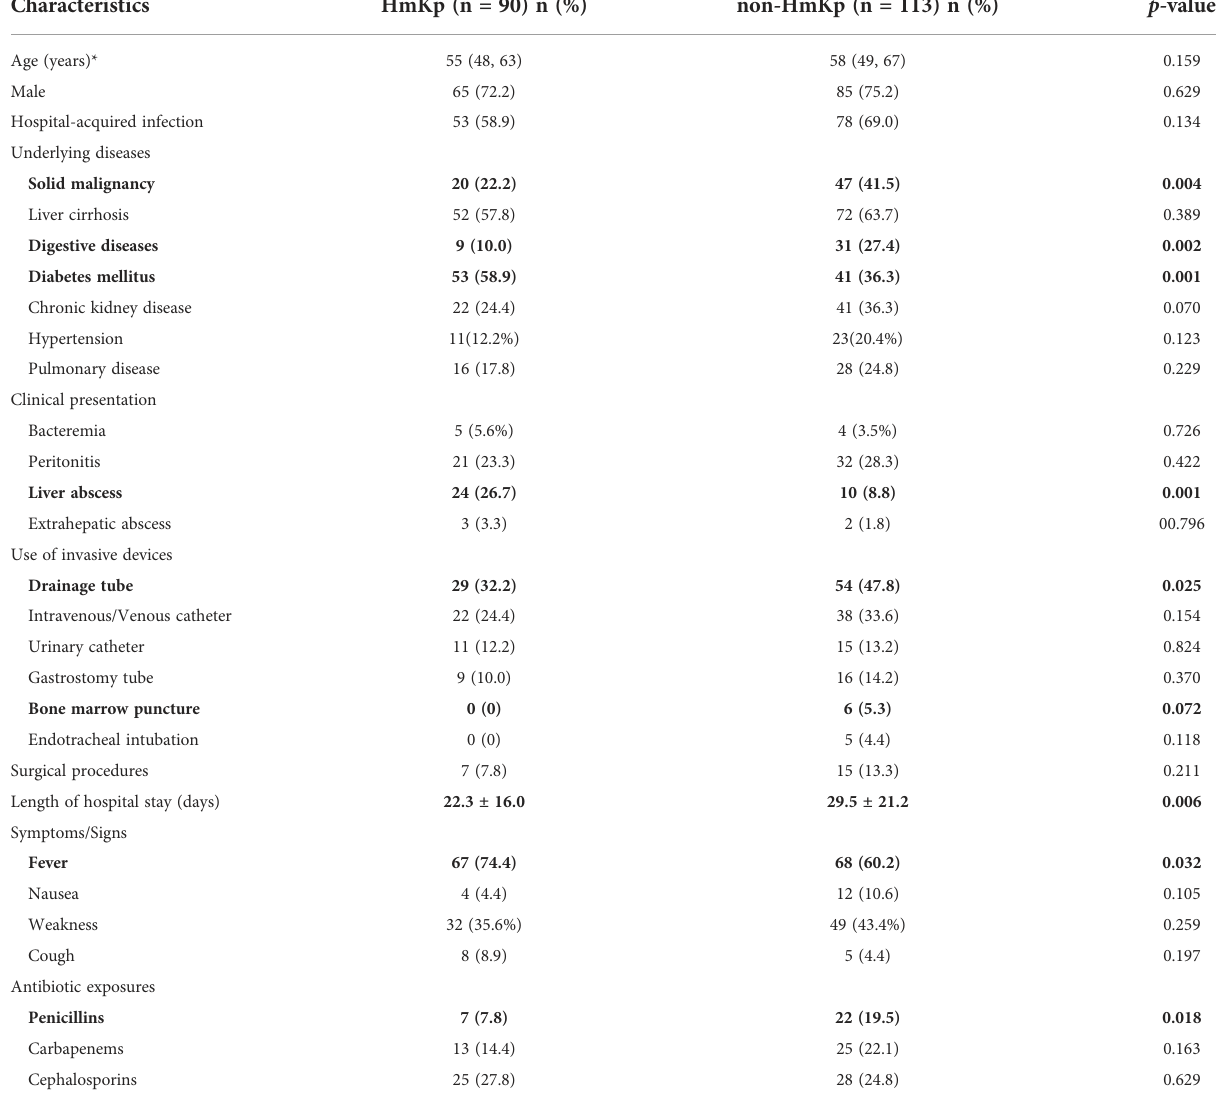
TABLE 1 Demographic and clinical characteristics of 203 patients with hypermucoviscous Klebsiella pneumoniae (HmKp) or non- hypermucoviscous K. pneumoniae infection. Characteristics